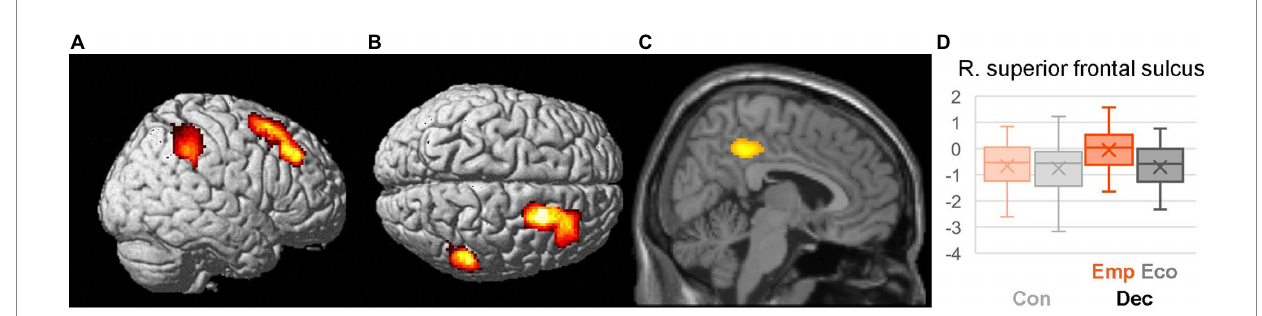
FIGURE 3 Differential activation during helping decision (EmpDec > EcoDec). Significantly higher activation during the thinking period of the context presentation for Emp than for Eco scenario (EmpDec_think > EcoDec_think) is presented on the cerebral surfaces from the right (A) and top (B) as well as on the parasagittal section ( x = 6) (C) . Boxplot (D) shows the activation profile of the right superior frontal sulcus during Dec_think period. Other details are the same as for Figure 2.